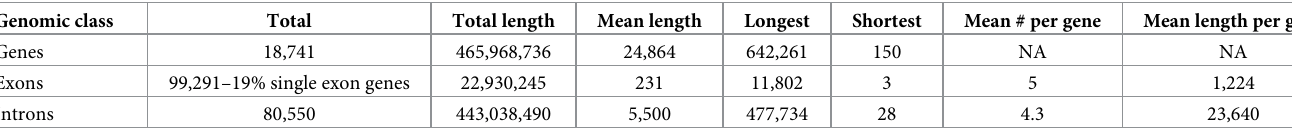
Table 3. Results from genome annotation, lengths in